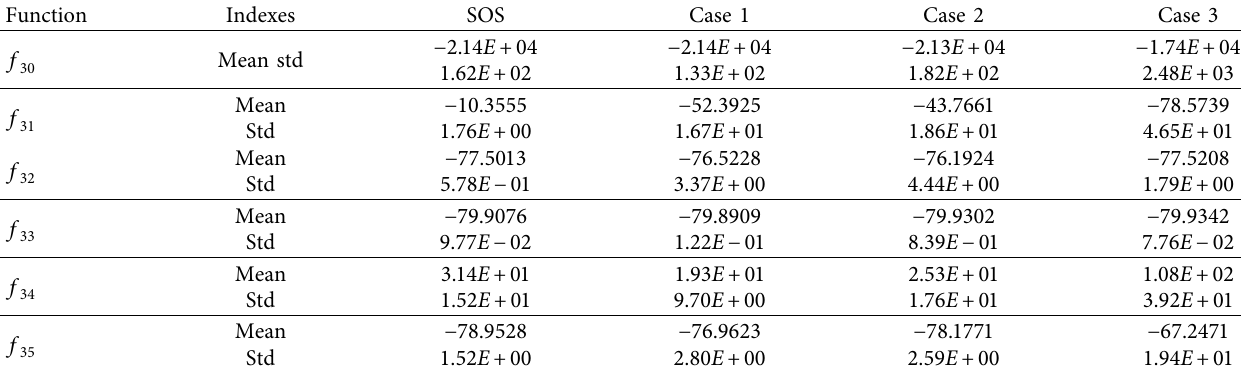
Table 10: Efect of the three cases on the SOS for shifted and biased multimodal functions.